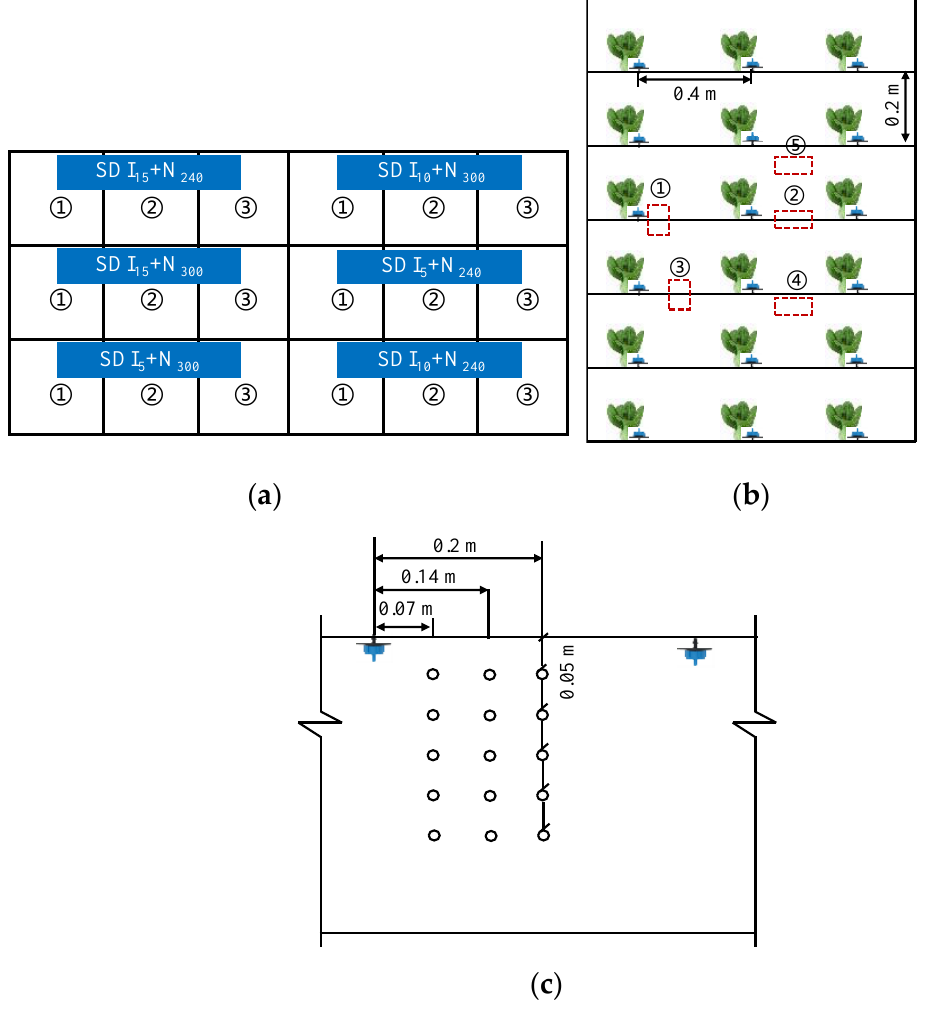
Figure 1. Experimental layout of subsurface drip irrigation system. Treatment layout (a), plot layout (b), and horizontal distances from the dripper point (c).